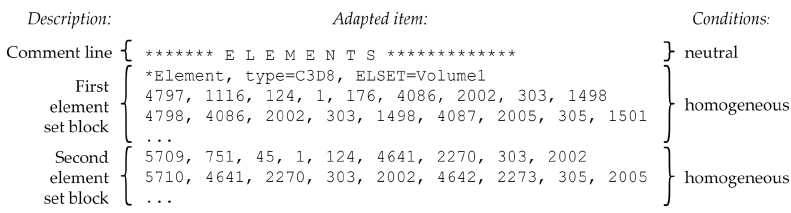
Figure 14. Adapted, compatible element sets for an error-free import into Z88.